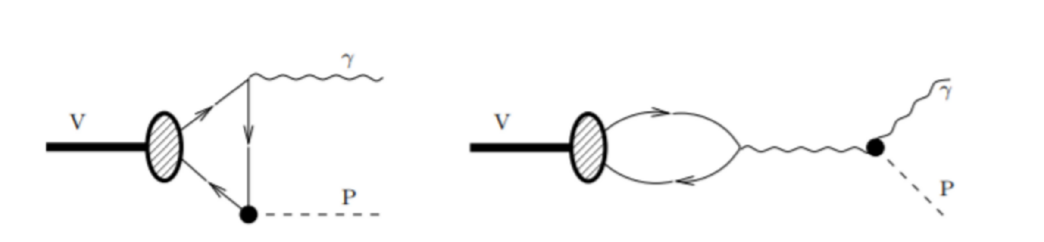
Figure 3 . Feynman diagrams of sgoldstino P production in flavorless meson V decays emanated by flavor-conserving pseudoscalar sgoldstino P couplings [18]. Solid lines indicate quarks forming the meson. Similar diagrams contribute to scalar S